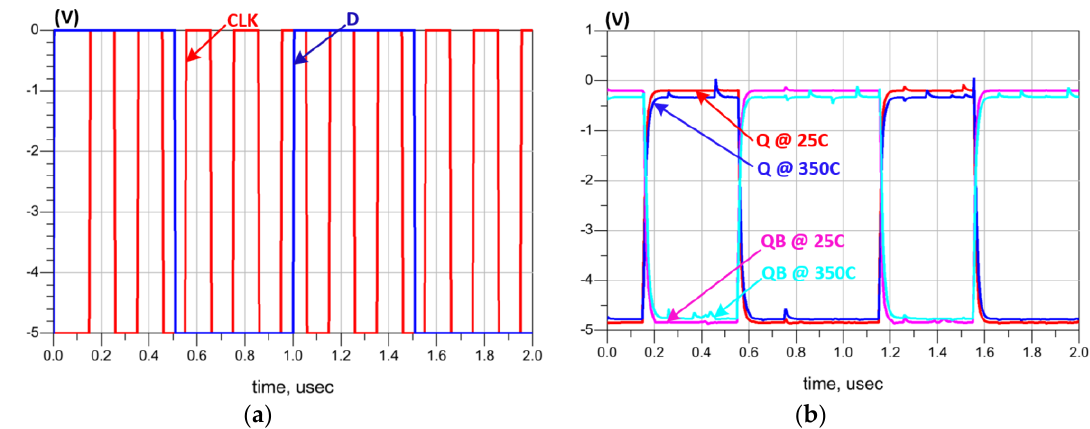
Figure 11. D-Flip Flop simulation results: ( a ) Input signals; ( b ) Output Data.